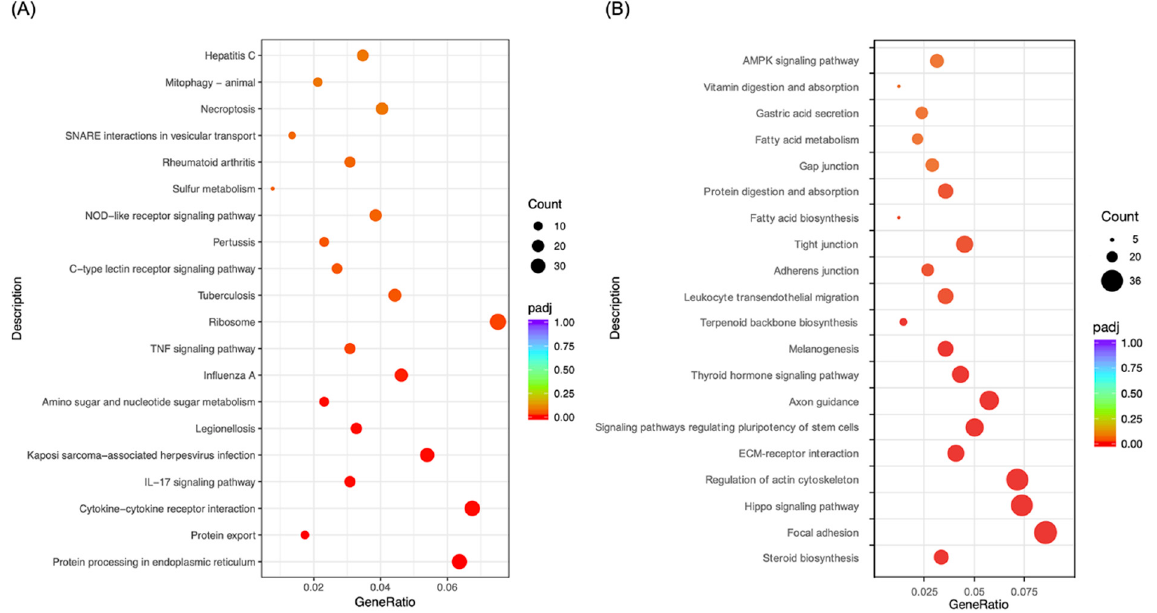
Figure 4. Functional annotation of the differentially expressed genes (DEGs, p adj < 0.05 and fold change > 2) in ruminal epithelial cells (RECs) based on Kyoto Encyclopedia of Genes and Genomes (KEGG) pathway analysis. ( A ) KEGG pathway of the overlapping DEGs that were downregulated in the Morusin+LPS group compared with LPS group and upregulated in the LPS group compared